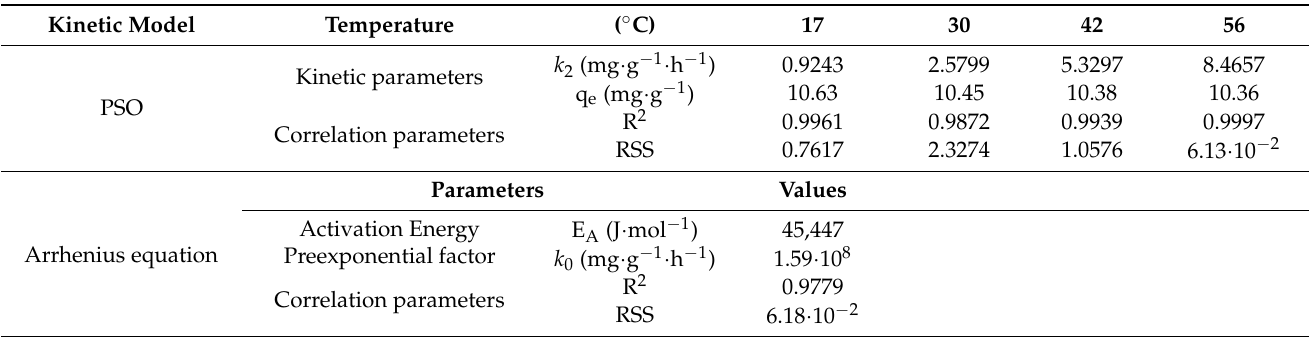
Table A5. Adjusted kinetic and correlation parameters of different kinetic models fitted to the experimental data of variable temperature during adsorption of hexavalent chromium onto CCNC and Arrhenius equation parameters and thermodynamic